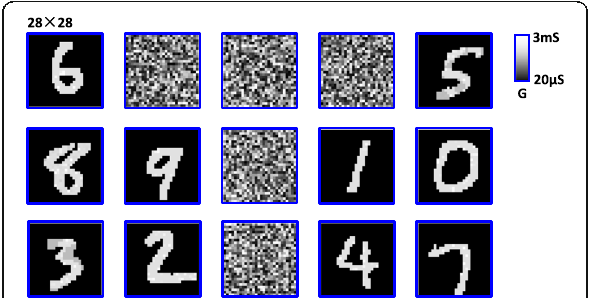
Fig. 7 Simulated learning results. Ten handwritten digits from MNIST database have been learned and classified by the